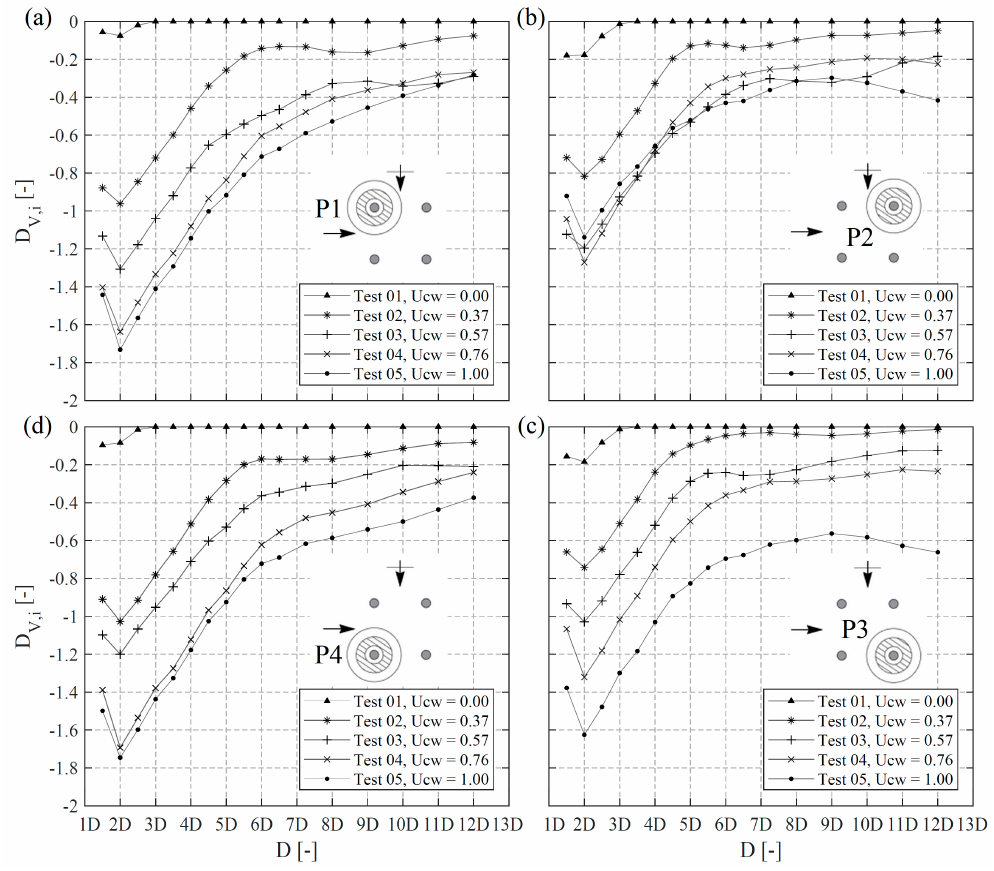
Figure 14. Local, nondimensional erosion depth D V (see Equation (6)) plotted over increasing diameters D around pile 1–4 ( a – d ), inner graphical subset of figure a–d is showing the related pile location, current (0 ◦ from left to right) and wave (90 ◦ perpendicular to the current) direction.